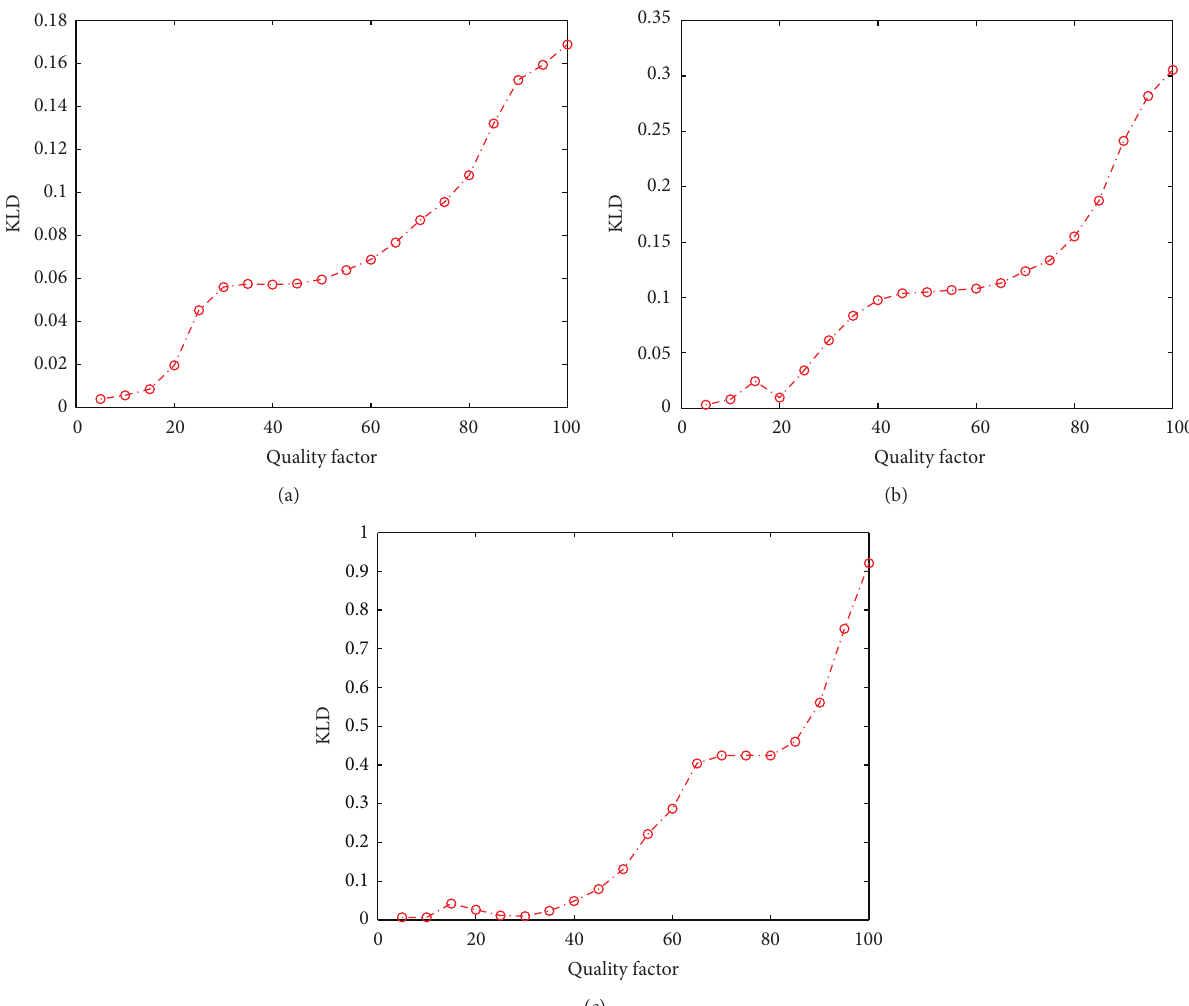
Figure 5: Average KLD between Θ attack (c) for Rbst QF = 90